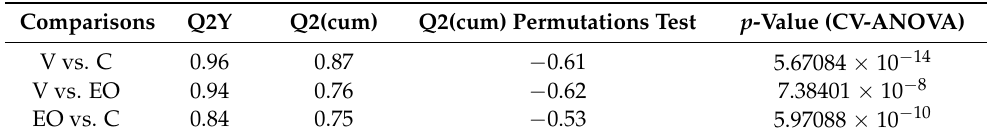
Table 1. Evaluation of the predictive capacity of different supervised models (OPLS-DA) comparing the three groups (EAS, V, and C). All parameters indicate models with good predictive capacities and low level of